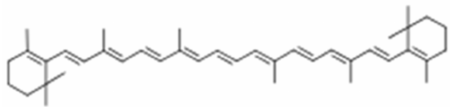
Figure 6. General structure of carotenoids— β -carotene